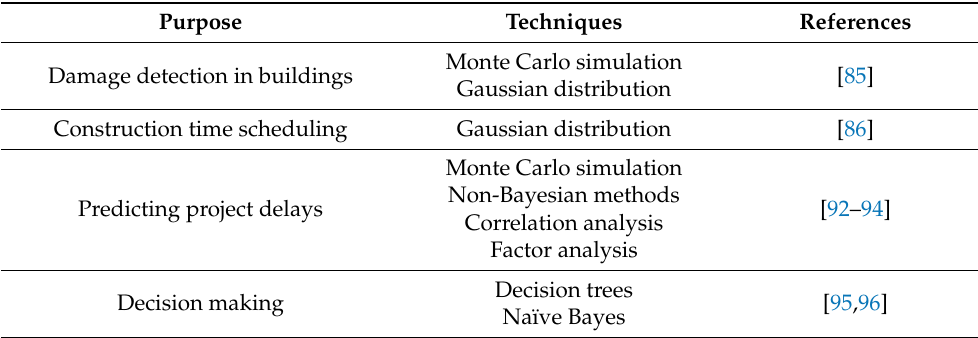
Table 1. Use of statistical models in